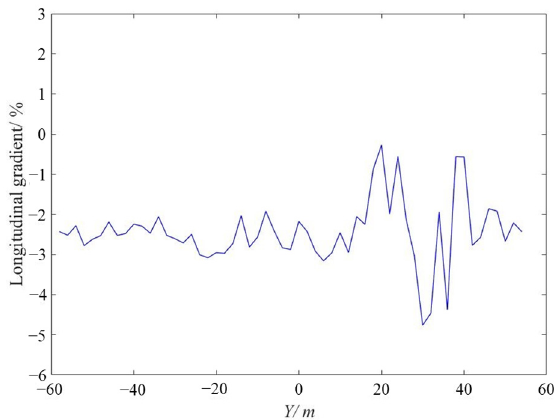
Figure 11. Transformed boundary and centerline of the main road.